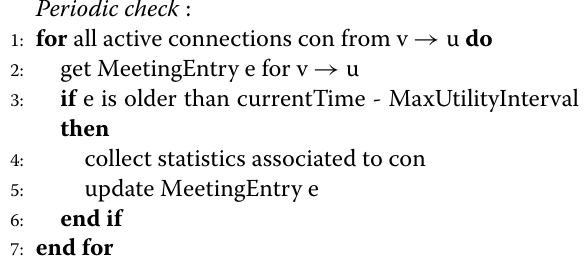
Algorithm 2 Contact-aware trigger for utility